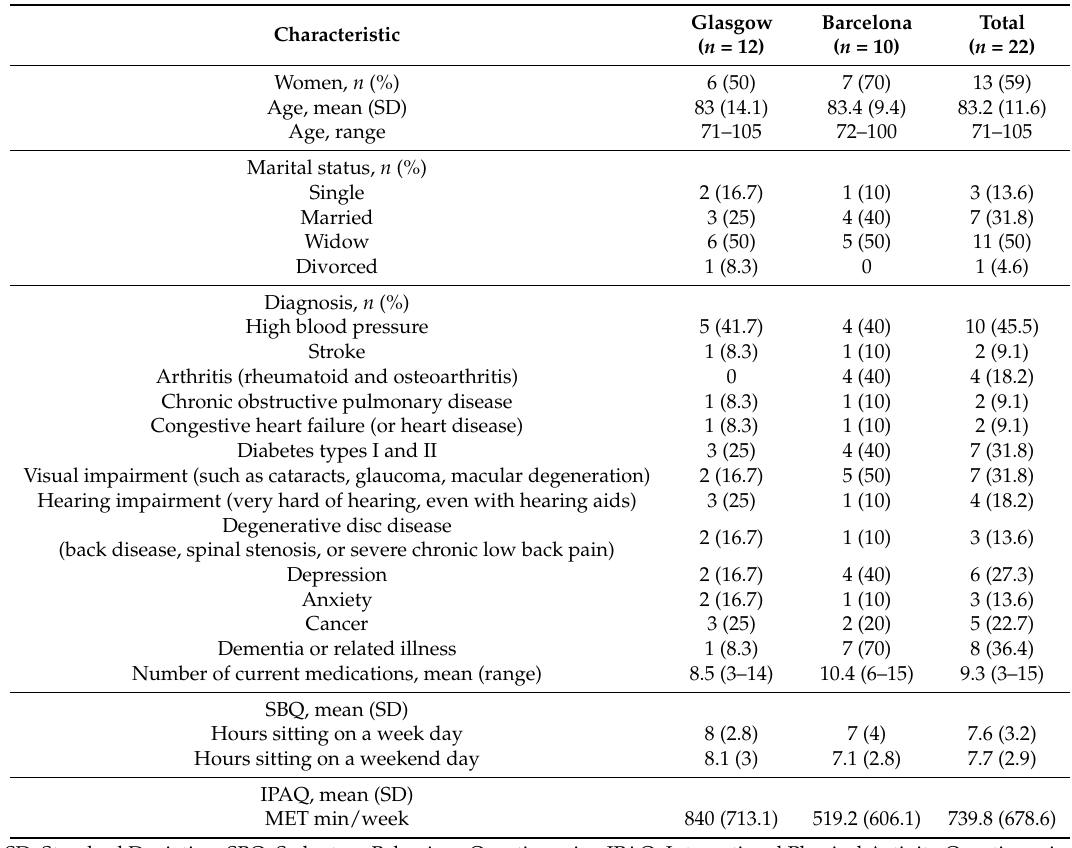
Table 1. Characteristics of care home residents ( n =